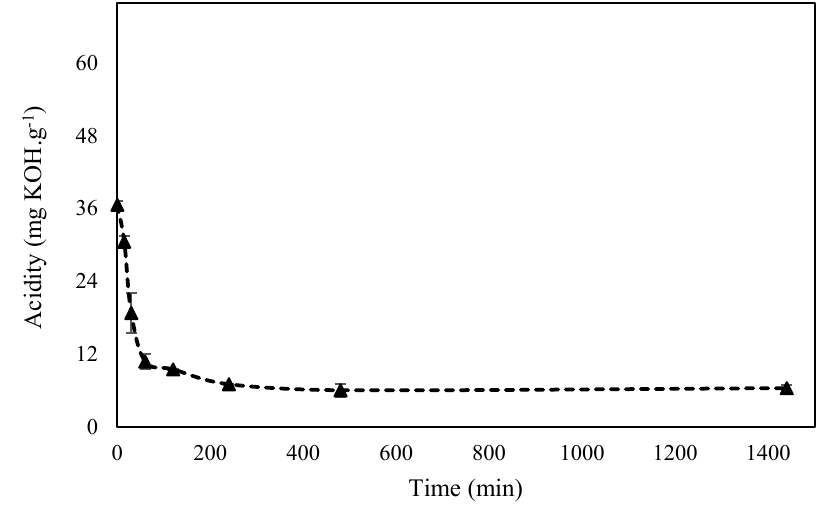
Figure 4. Acidity reduction during heterogenous enzymatic esterification reaction at 35 °C for 6:1 methanol:oil molar ratio with stepwise alcohol addition (5 wt.% catalyst). Errors bars show maximum and minimum values of the experiments in duplicate.